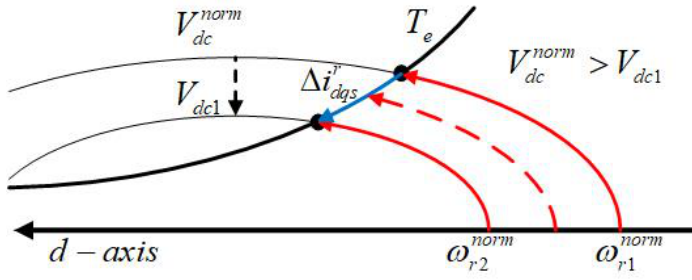
Figure 3. d -/ q -axis currents trajectory on DC-link voltage